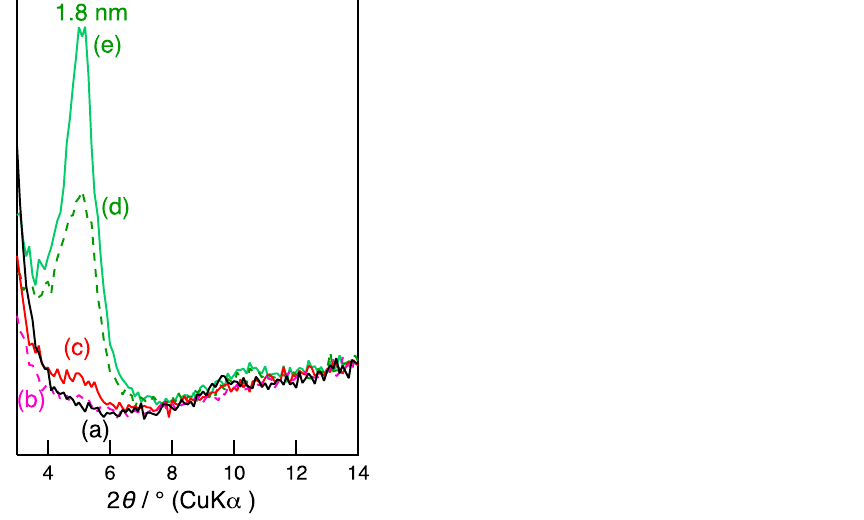
Figure 2. XRD patterns of polyFe/LIIm composites ( a ) 3/0.1, ( b ) 3/0.5, ( c ) 3/1, and ( d ) 3/5 and ( e ) a reference LIIm cast films on quartz glass.